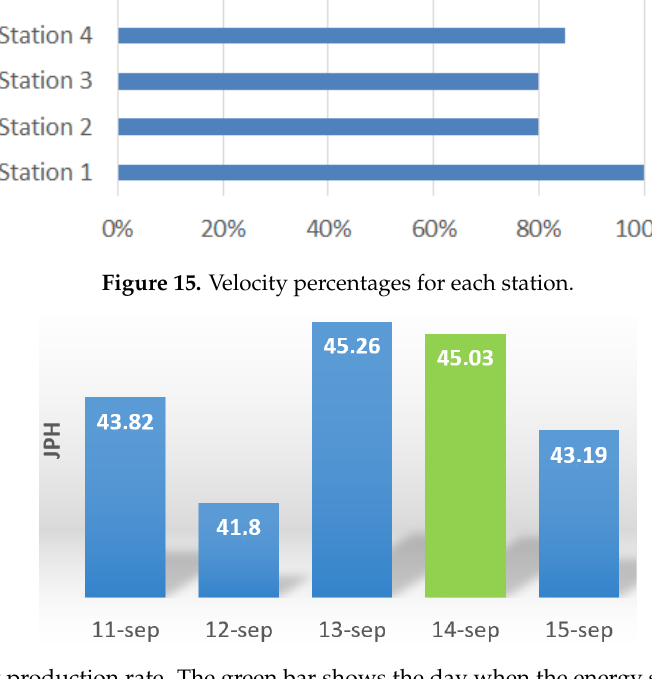
Figure 16. Daily production rate. The green bar shows the day when the energy saving system was switched